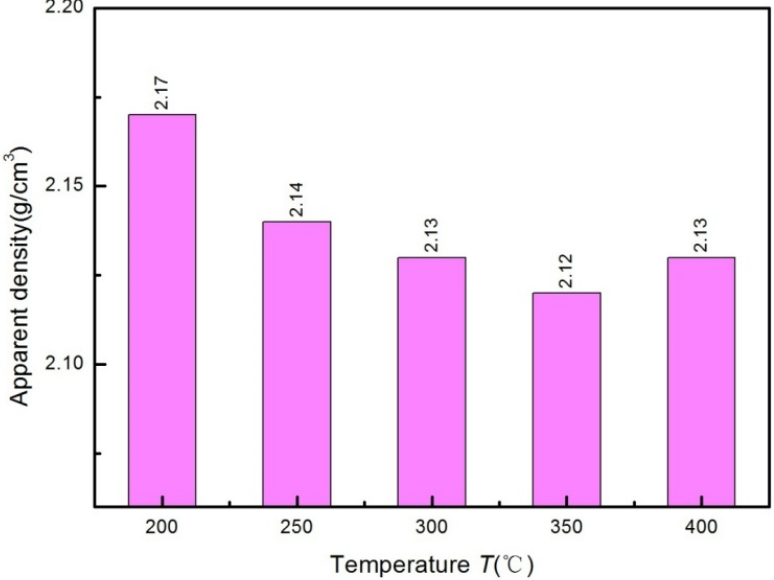
Figure 10. Effects of reduction temperature on apparent density (reduction time 90 min).